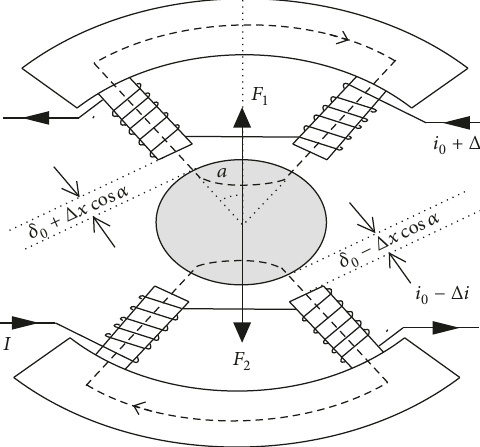
Figure 4: Active control for multinode unbalanced vibration in cutting base on active magnetic